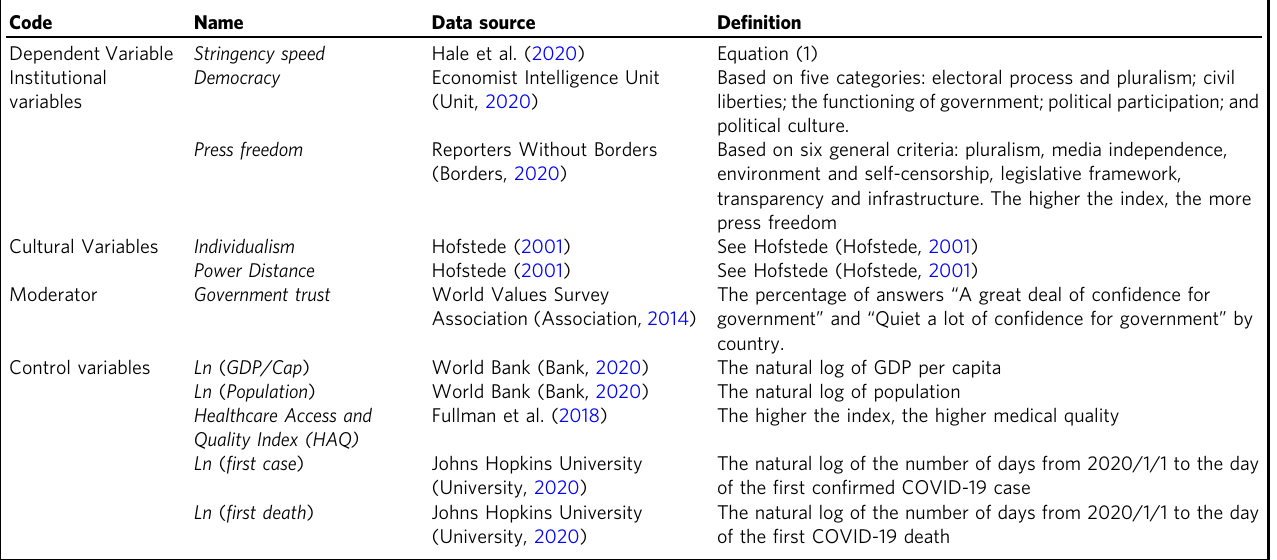
Table 1 Variable de fi